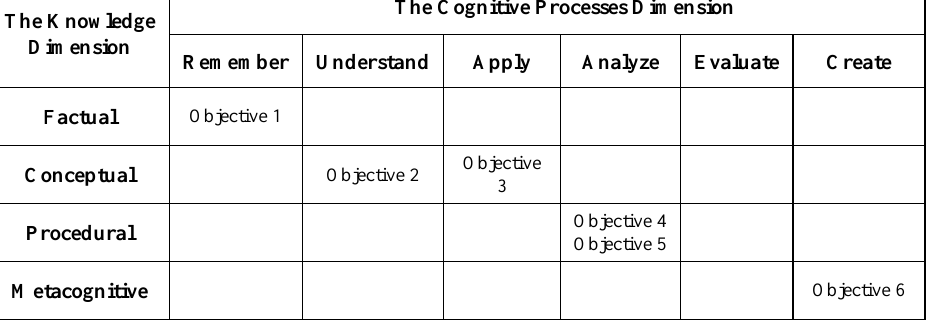
Fig. 2 . Model of Learning